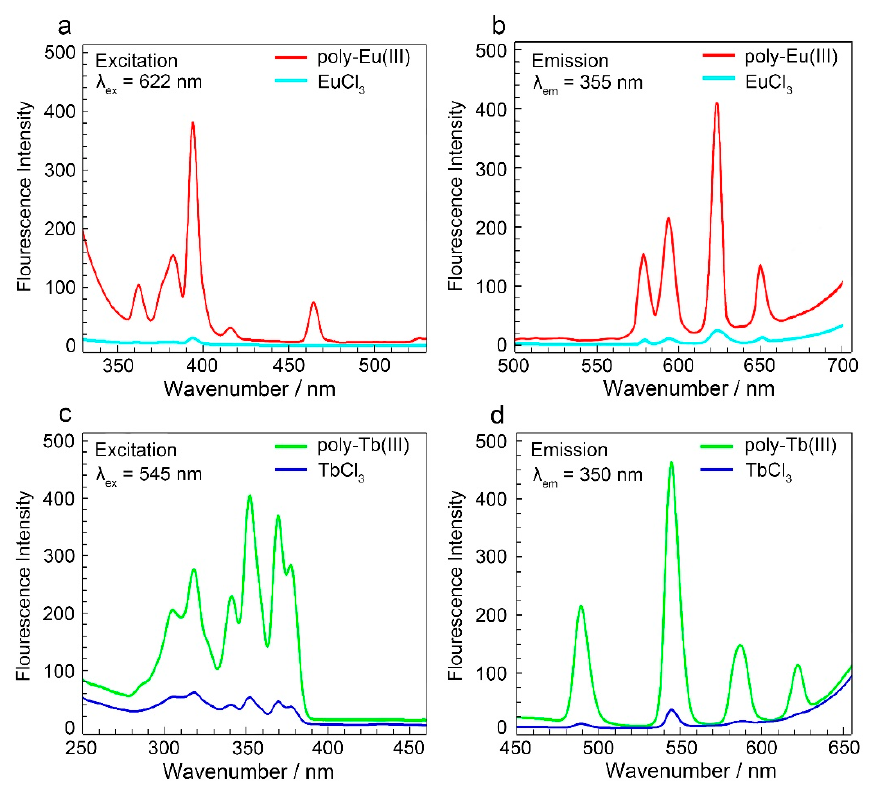
Figure 5. Excitation spectra of ( a ) poly-Eu(III), EuCl 3 , and ( b ) poly-Tb(III), TbCl 3 and emission spectra of ( c ) poly-Eu(III), EuCl 3 , and ( d ) poly-Tb(III), TbCl 3 (concentration 1 wt.% in EtOH/H 2 O ( v / v = 1:1) mixed solvent at 25 °C).